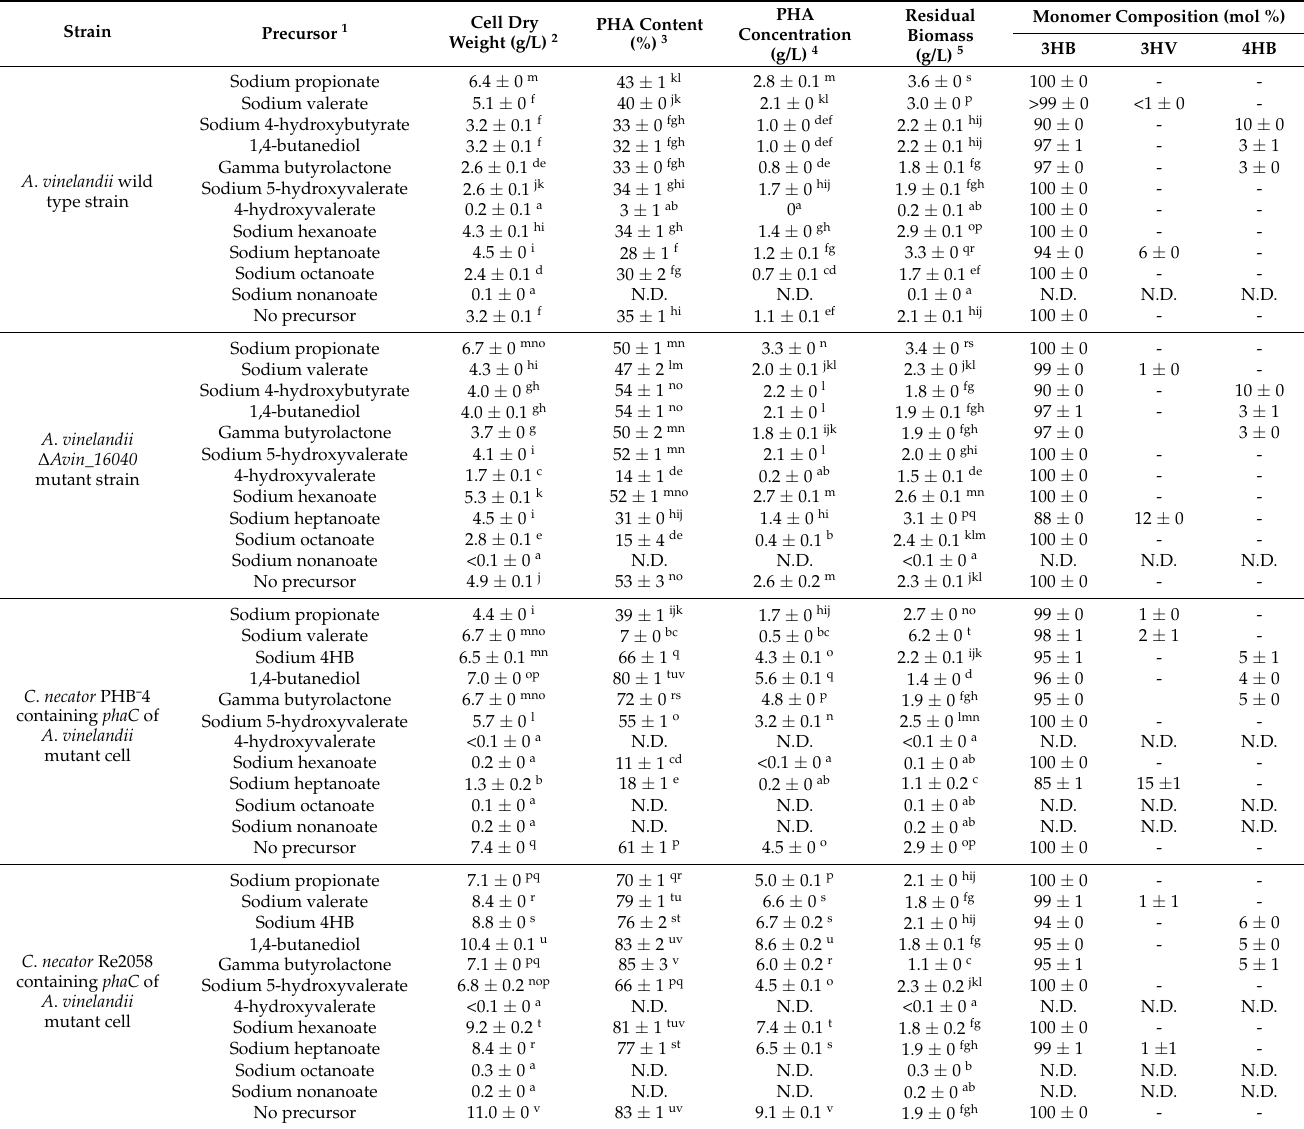
Table 3. Biosynthesis of different PHAs by A . vinelandii wild type strain, A . vinelandii ∆ Avin_16040 mutant strain, C . necator PHB¯4 containing phaC of A . vinelandii mutant cell and C . necator Re2058 containing phaC of A . vinelandii mutant cell supplemented with 2 g/L of